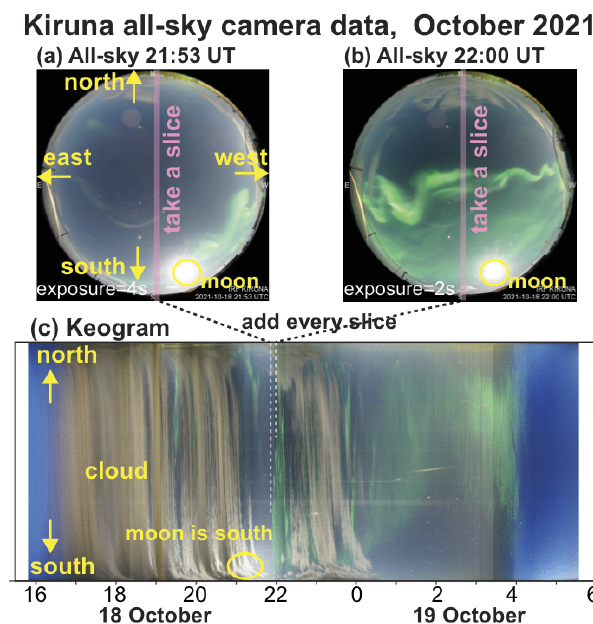
Figure 2. An example of the keogram that is created from a time series of the all-sky camera (ASC) images. Panels (a) and (b) show the ASC images during the “local-arc breaking” (see text for expla- nation): (a) 21:53UT with 4s exposure and (b) 22:00UT with 2s exposure. Only the north–south slice of each image (red shaded area in the middle) is used to create (c) the keogram, a time series of the activity (but with a mixed exposure times) seen in the north–south meridian.